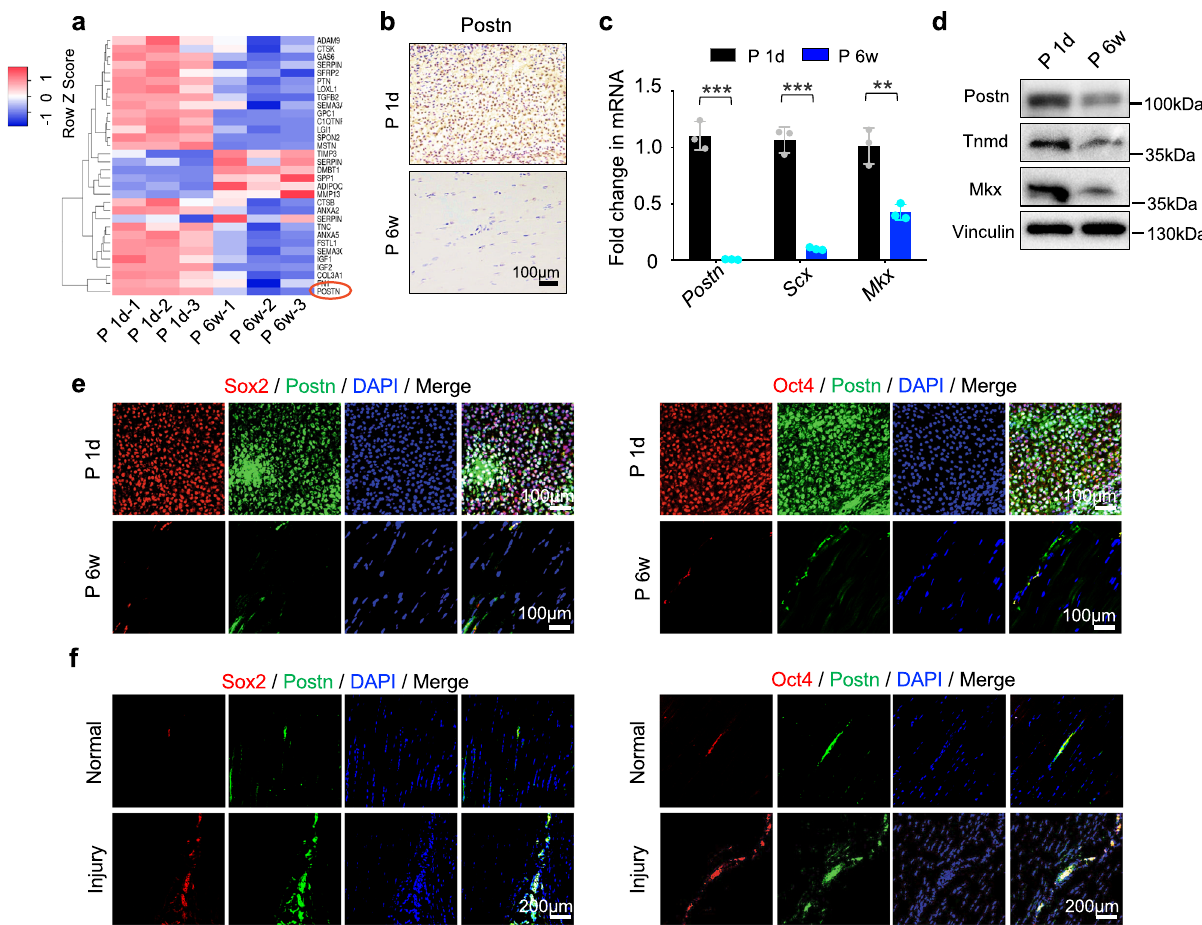
Fig. 1 Postn is highly expressed in postnatal tendon development and endogenous tendon injury repair. a Heatmap of the 32 differentially expressed gene pro fi les between neonatal and 6 – 8-week-old tendons ( n = 3 rats per group). b Immunohistochemistry of Postn expression in the P 1d and P 6w Achilles tendons ( n = 3 rats per group). c , d RT-qPCR of Postn, Scx, and Mkx expression ( c , n = 3 independent experiments, by two-tailed Student ’ s t test: *** P < 0.001, ** P < 0.01) and Western blotting of Postn , Tnmd, Mkx at P 1d and P 6w ( d ). e Immuno fl uorescence staining of Postn, Sox2, and Oct4 in the rat Achilles tendon between P 1d and P 6w groups ( n = 5 rats per group). f Immuno fl uorescence staining of Postn, Sox2, and Oct4 in normal and injured Achilles tendons at 1 week postoperatively ( n = 5 rats per group). Data are presented as mean ± SD. Exact P values were given in the Source Data fi